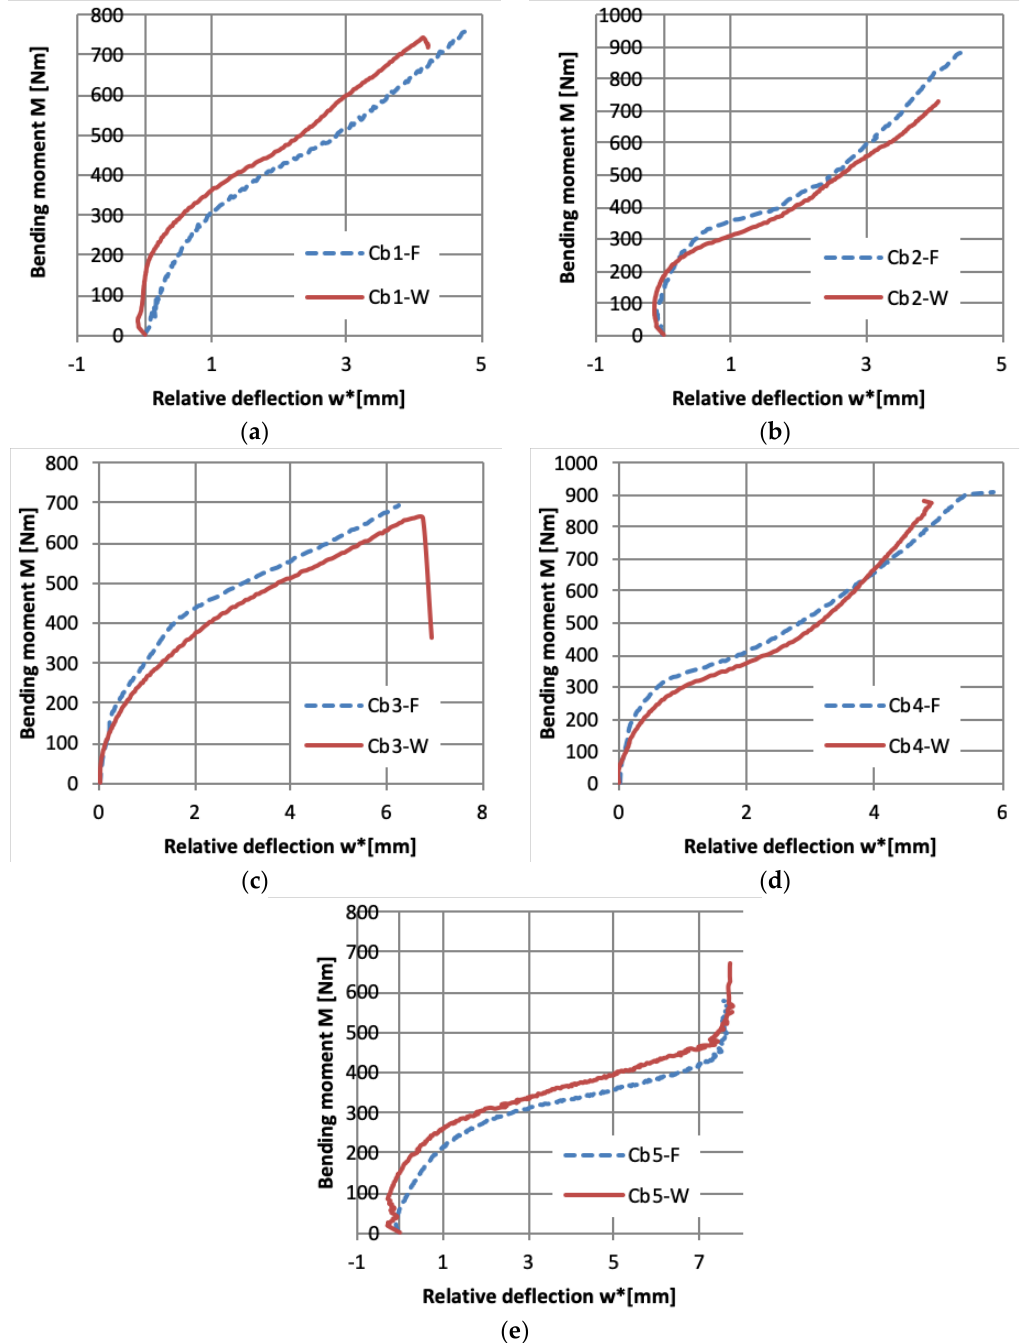
Figure 8. Bending moment vs. relative deflection for pre-damaged beams with different layer arrangements. ( a ) beams with layups Cb1; ( b ) Cb2; ( c ) Cb3; ( d ) Cb4; ( e ) Cb5.